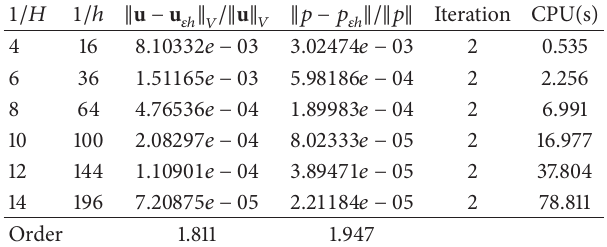
Table 3: Numerical relative error for pressure with 𝐻 = 1/14 and ℎ = 1/115 .